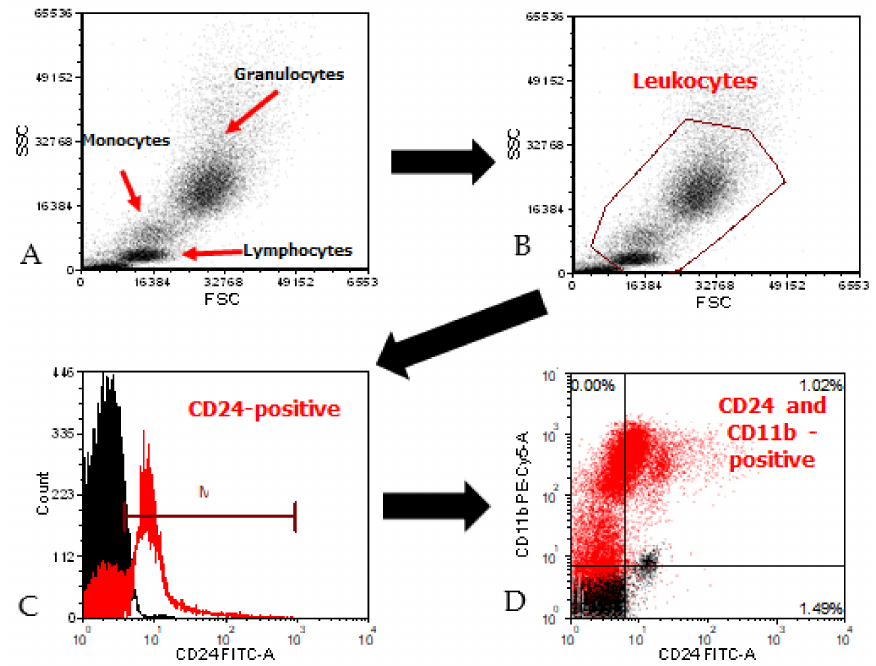
Figure 1. Flow cytometry data analysis. Dot plot of FSC and SSC distinguishes between populations of cells ( A ) and a gate has been applied to identify the leukocytes population ( B ). A total of 30,000 events or cells within the gate were further analyzed and doublet discrimination performed by plotting FSC-H vs. FSC-A. Data are expressed in a histogram to evaluate the relative expression of CD24 ( C ). Two-parameter dot plots display two measurement parameters, FITC (CD24) and PE-Cy5.5 (CD11b) ( D ).